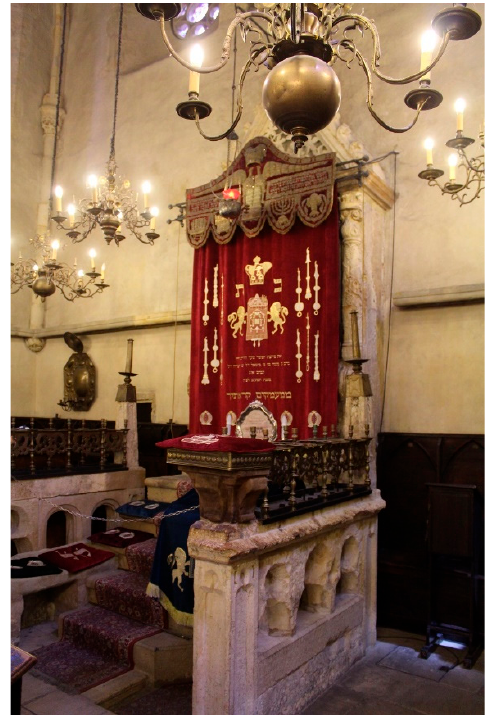
Figure 5. Old New Synagogue, Prague (Creative Commons, Deror Avi).